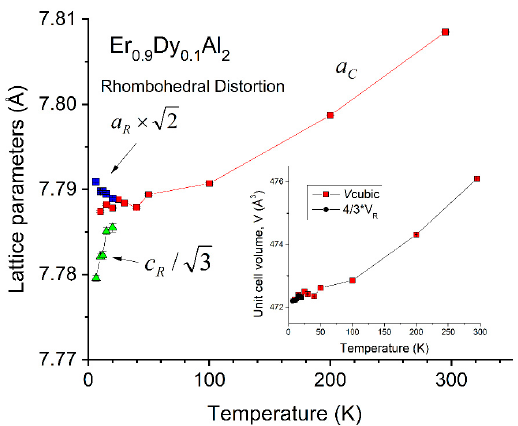
Figure 3. Lattice parameters of Er 0.9 Dy 0.1 Al 2 as functions of temperature. Inset shows unit cell volume as a function of temperature.